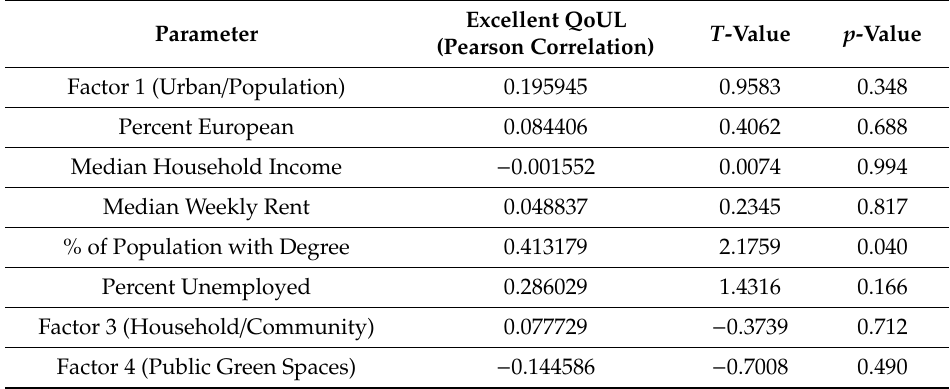
Table 10. Results of the partial regression analysis predicting excellent QoUL from the five Factor 2 variables and three